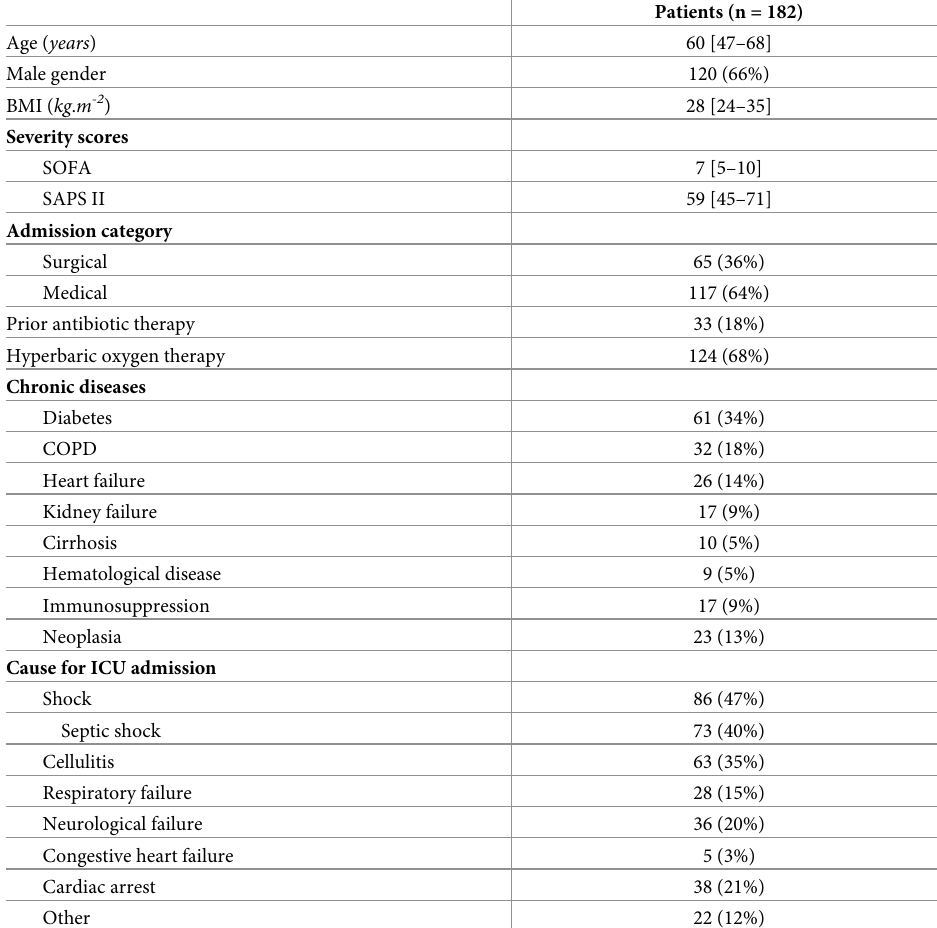
Table 1. Patients included in study: Data upon ICU